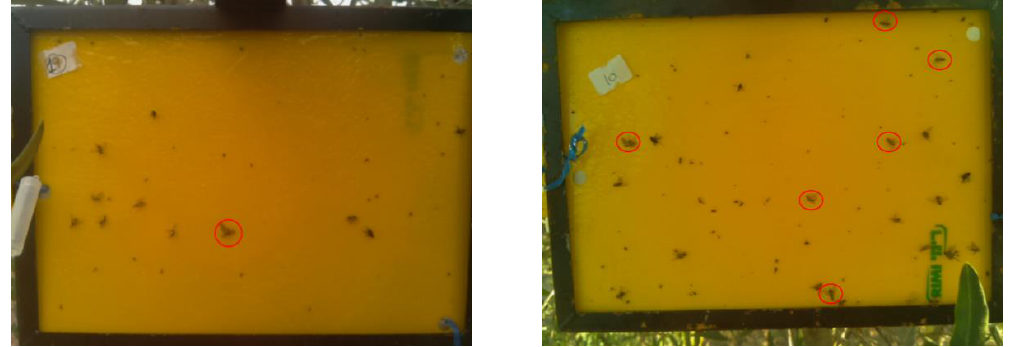
Figure 9. Images sent by the e-traps where B. oleae adults were identified (red circles).